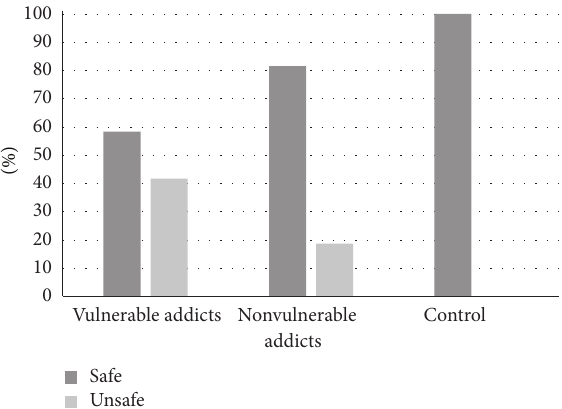
Figure 2: Percentage of condom usage in sexual relations in three groups.